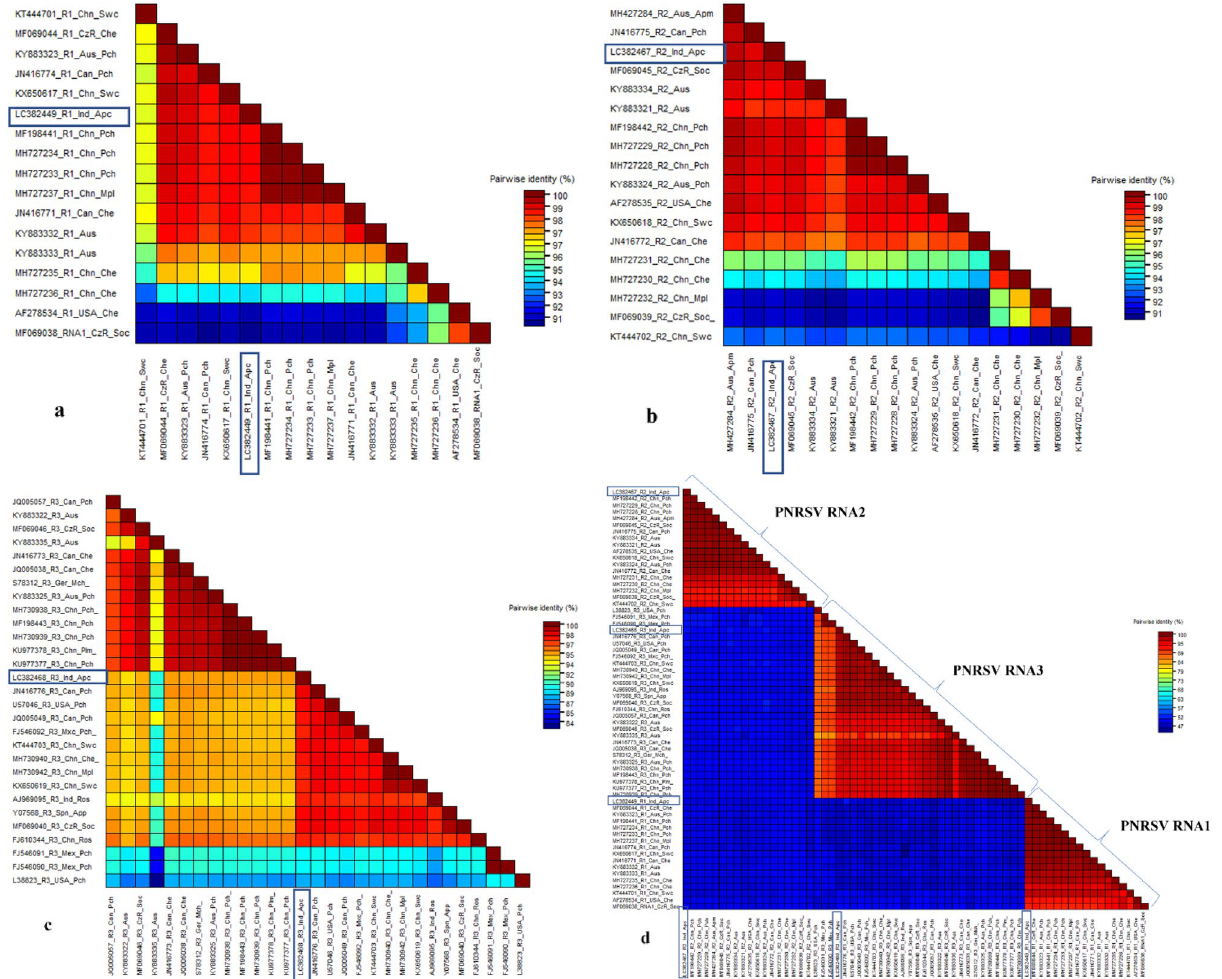
Figure 5. Sequence Demarcation Tool analysis displays the percentage pair-wise identity of Indian isolate of ( a ) RNA1, ( b ) RNA2, ( c ) RNA3 and ( d ) combination of RNA1, 2 and 3 sequences with other RNA1, 2 and 3 sequences of PNRSV from different geographical